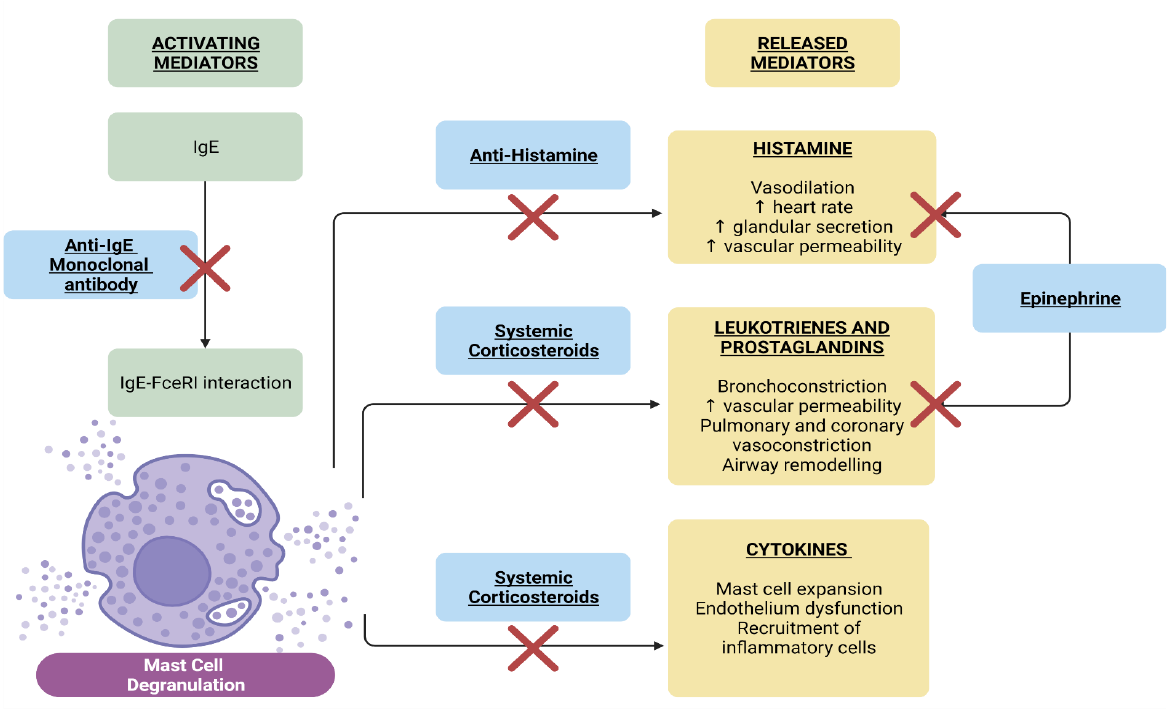
Figure 2. Proposed mechanism and therapeutic targets of immediate hypersensitivity reactions. For vaccine-induced immediate hypersensitivity reactions, potential targets can be used to attenuate mast cell degranulation through medicines or biologic agents. Anti-IgE monoclonal antibodies inhibit IgE– FcεRI interaction that initiates degranulation. Epinephrine acts as a physiologic antagonist of the effector mediators. Effector mediators released are inhibited by antihistamines and systemic corticosteroids. The symbol “X” represents it can block the pathway. ↑ : Increase. Abbreviation: IgE, immunoglobulin E; FcεRI, Fc epsilon receptor.